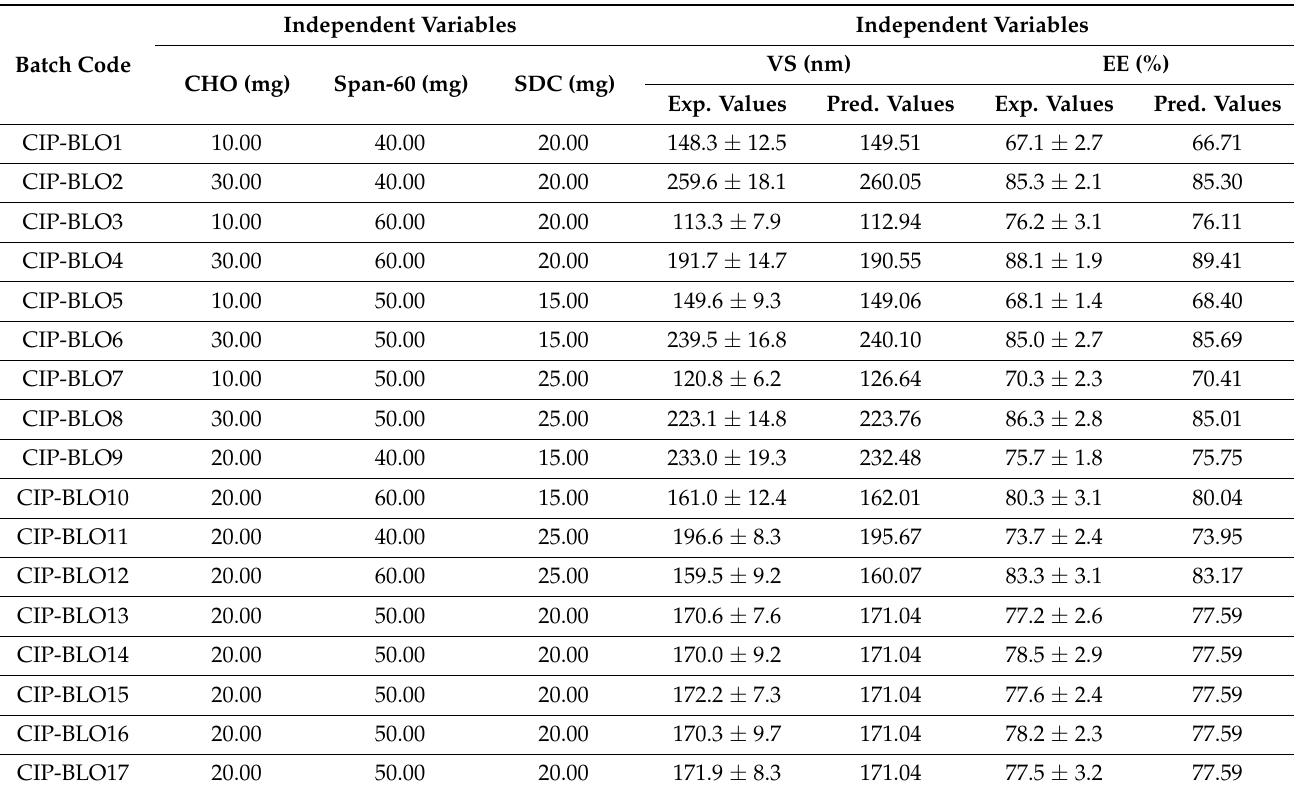
Table 1. Showing the composition of CIP-BLO formulations with their experimental and predicted values of responses.